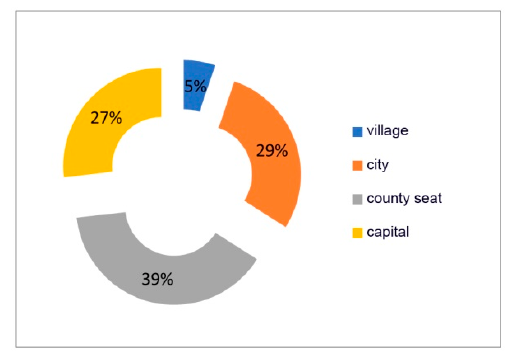
Figure 2. Type of residence. Source: own research, 2018.